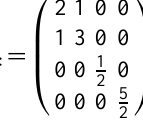
Fig. 7. Estimated variances ˆ σ 33 and covariance ˆ σ 23 when σ 12 is the only non-zero covariance ( Σ c ). The bias between the two estima- tors for both the variance and the covariance is due to the covariance not taken into account. The dashed lines indicate the correct values.